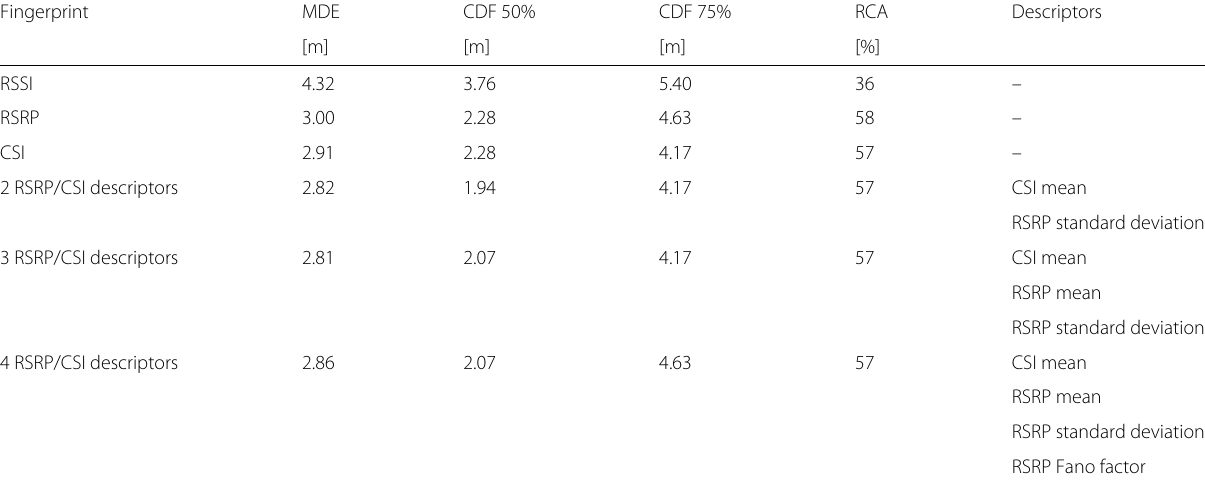
Table 4 Comparison of signal fingerprinting approaches based on RSSI, RSRP, CSI vectors, and RSRP/CSI descriptors (1 cell, 6 RBs)